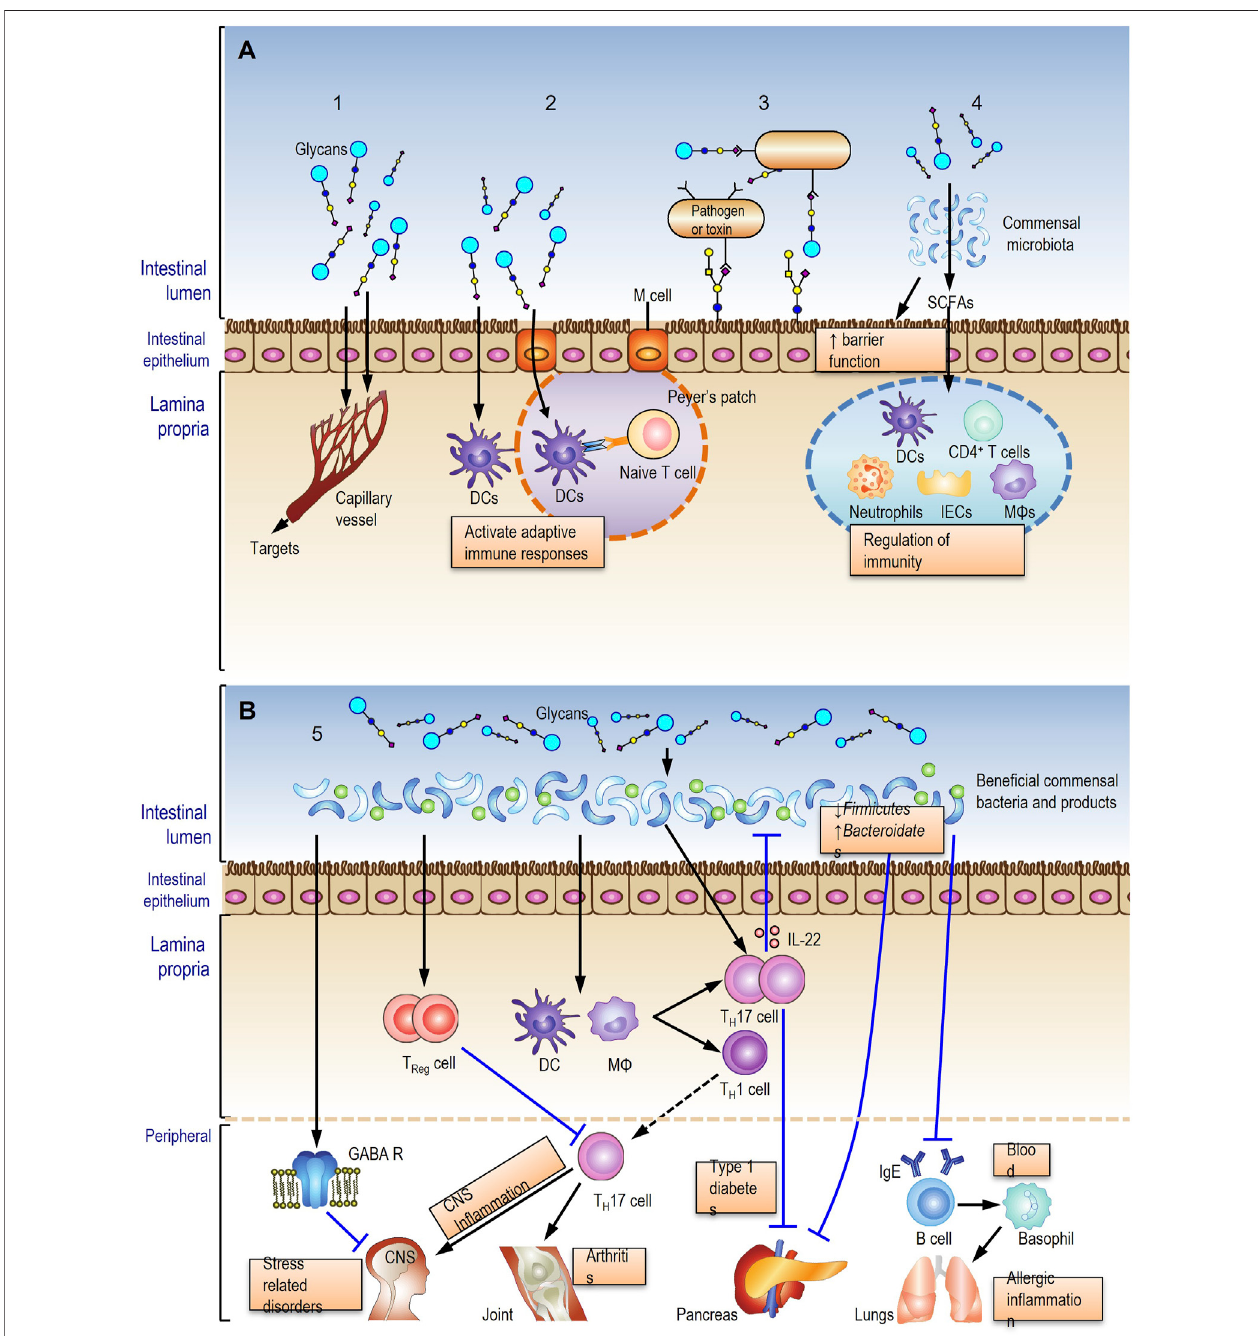
FIGURE 1 | Five potential action modes of oral herbal glycans. Modes 1-4 (A) and mode 5 (B) described in fulltext.